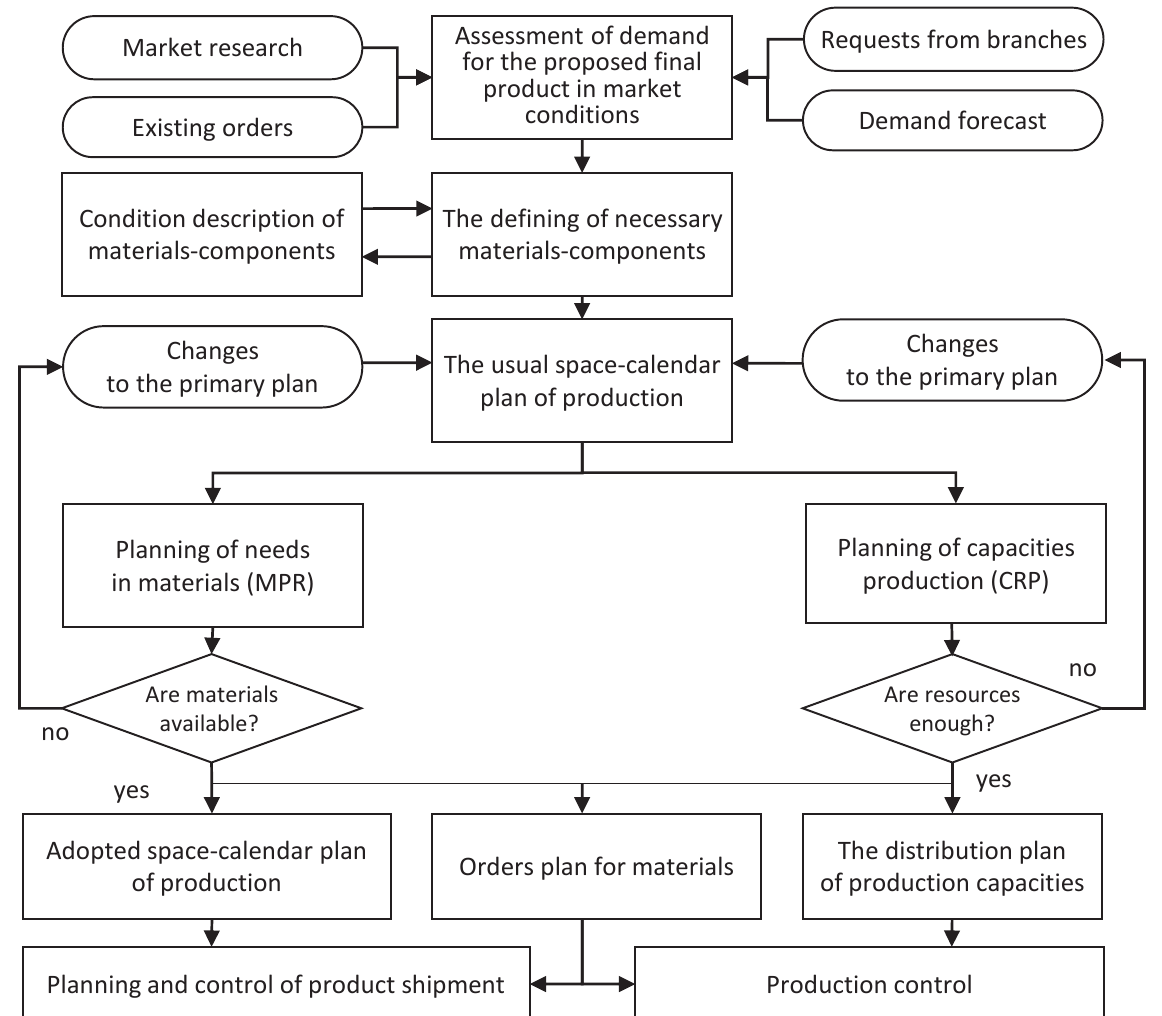
Figure A1. Algorithm of operational planning of production processes using a